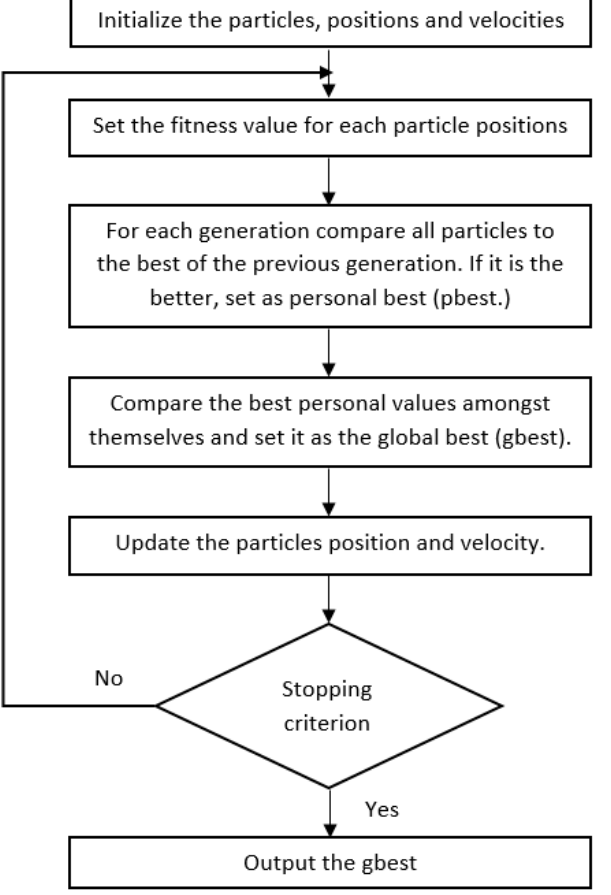
Figure 4. Flowchart of PSO algorithm.